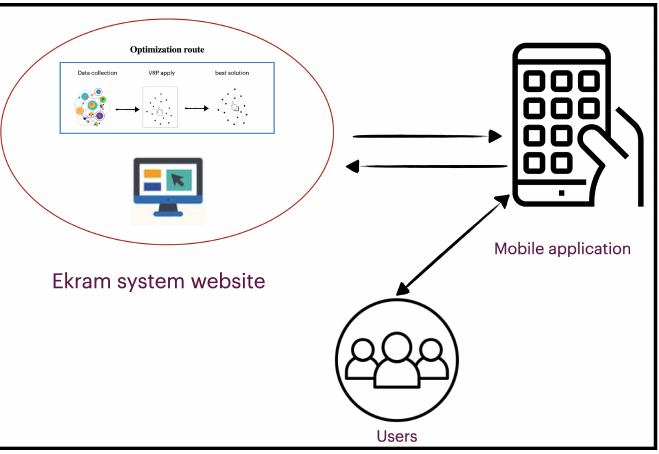
Figure 3. Ekram system with